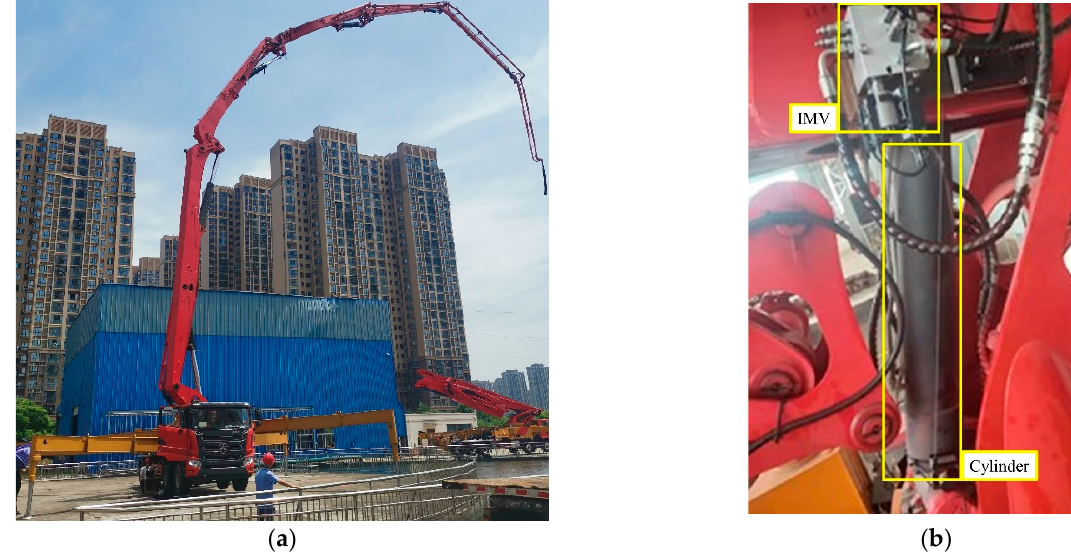
Figure 12. Truck-mounted concrete pump: ( a ) Picture of truck-mounted concrete pump with six- section boom; ( b ) boom section 1 cylinder and its IMV.